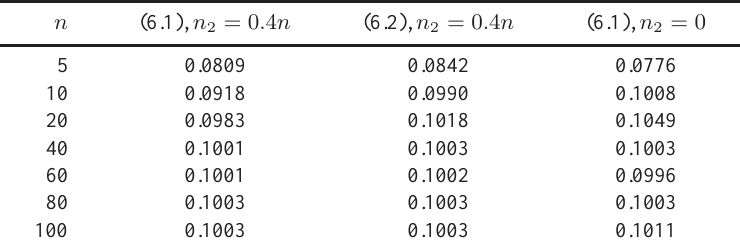
Figure 4. Solution | f ( t, 15) | by n = 100 , I = 0 . 01 , δ = 0 , ∆ = 10 . Table 2. The dependence of value F n = | f (1 , L ) | from n for I = 0 . 01 , δ = δ ( x ) , ∆ = 10